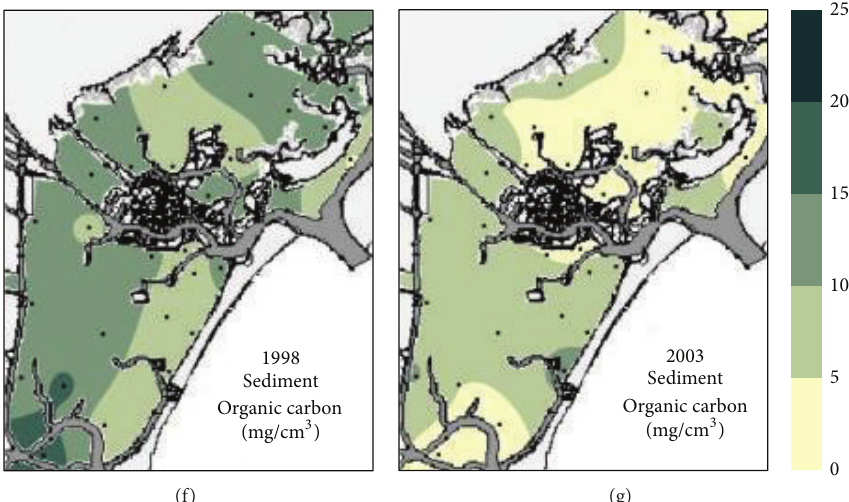
Figure 6: Spatial distribution of carbon concentrations in 2003. Total carbon (a), inorganic carbon (b), and organic carbon (c). Mean values and standard deviations shown on maps for whole lagoon (W) and northern (N), central (C) and southern (S) basins. Other maps indicate distributions in 1987 (d), 1993 (e), 1998 (f), and 2003 (g) in central